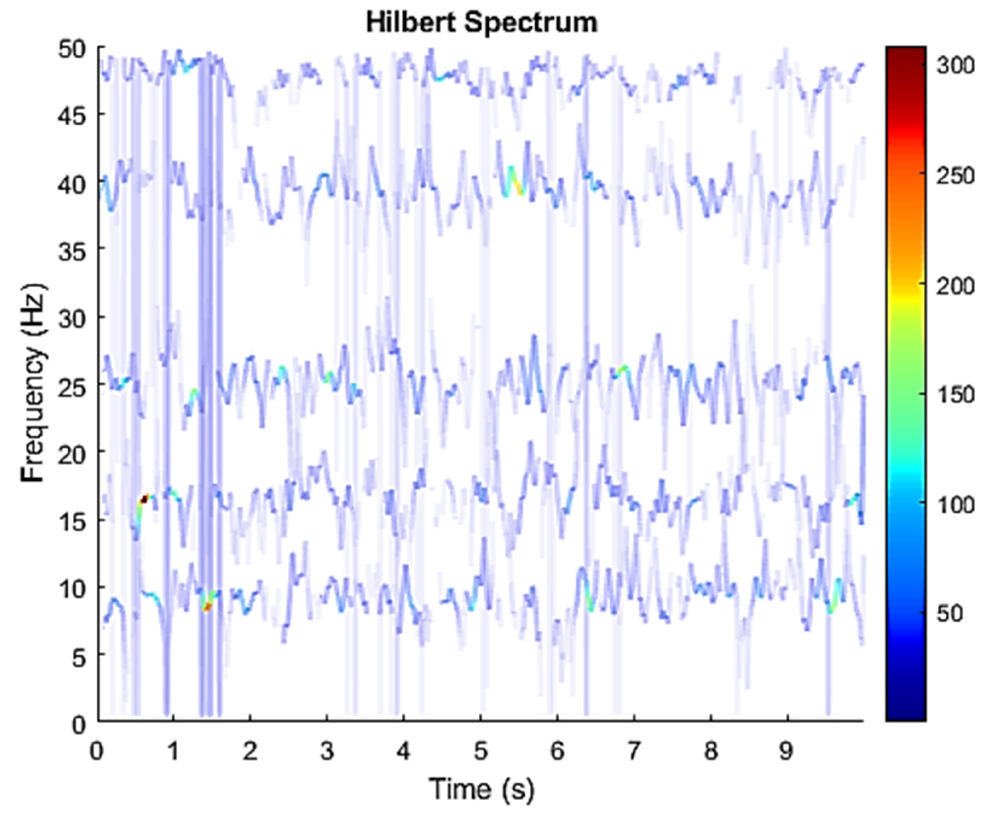
Figure 4. Hilbert Spectrum results of the VMD component obtained from the numerical simulation of the sensor.